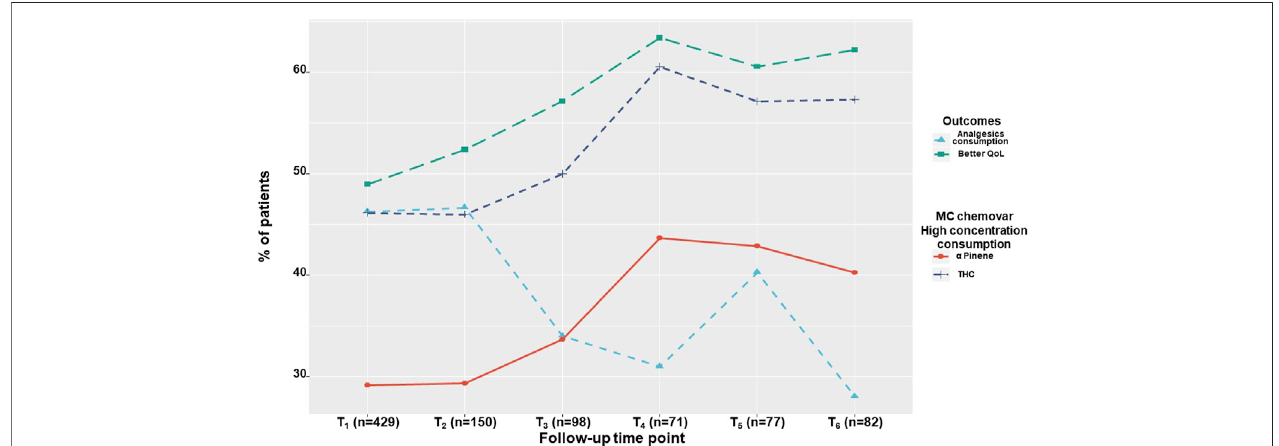
FIGURE 4 | Time-dependent outcome rates. The percentage of patients reporting on analgesics consumption and on ’ better ’ quality of life, alongside with the percentage of patients consuming high THC and α -pinene monthly doses, demonstrated for the study sample at one month intervals within a six-month period. QoL, Quality of life; THC, Δ -9-tetrahydrocannabinol; T1, One-month Follow-Up; T2, Two month Follow-Up; T3, Three month Follow-Up; T4, Four month Follow-Up; T5, Five month Follow-Up; T6, Six month